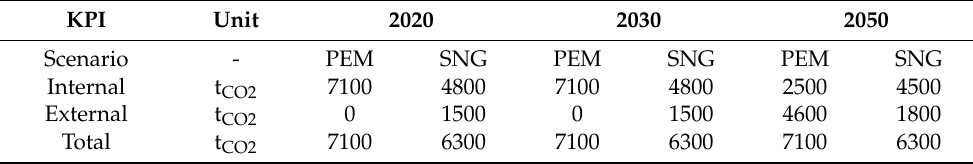
Table 7. Reduction of internal (scope 1) and external (grid) CO 2 emissions.